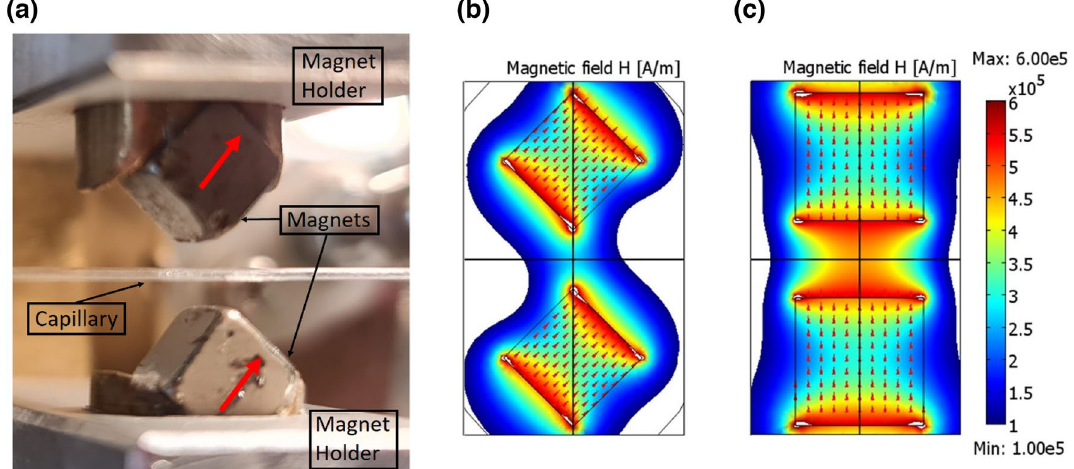
Figure 2. (a) Photo of the experimental MagD. ( b) Calculated magnetic field distribution generated by the magnets in edge-to-edge configuration. For comparison in ( c) we show magnetic field distribution simulated for magnets in face-to-face configuration. ( b,c) Have a common colour scale for magnetic field values and the arrows show the directions of magnets